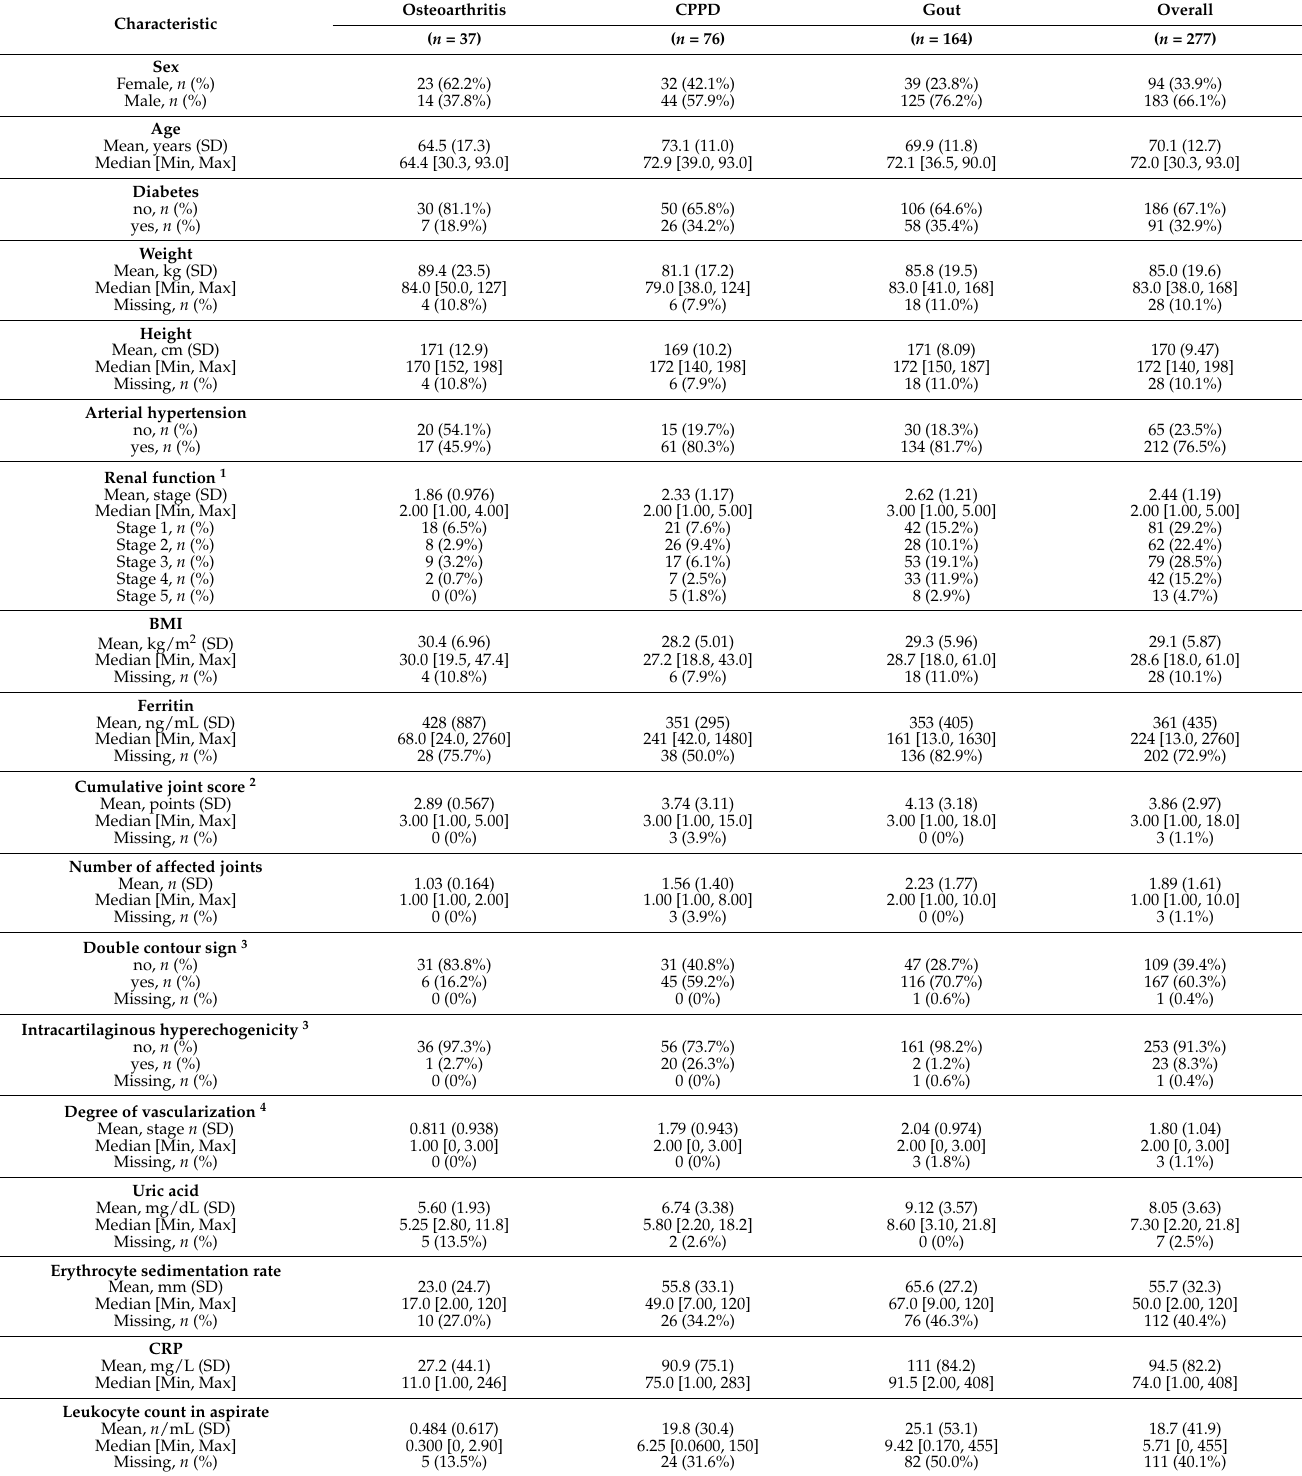
Table 2. Patient